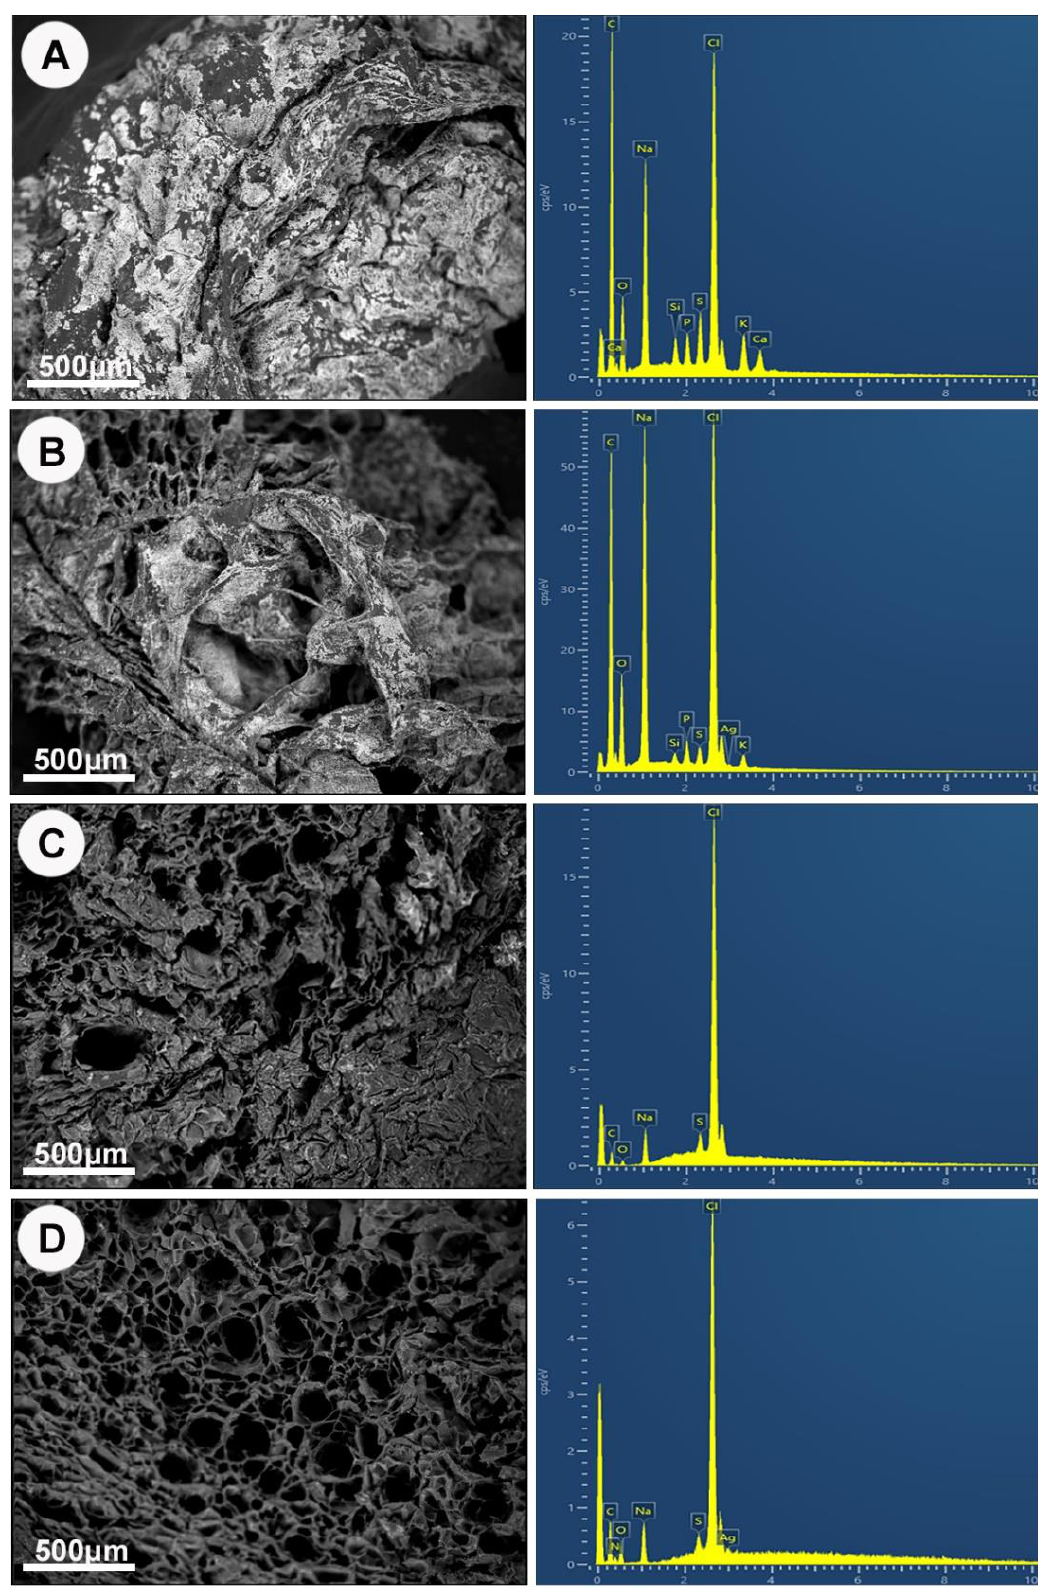
Figure 5. SEM images and respective EDS Spectra of both hydrogels with and without 100 μ g/mL AgNP. ( A ) HyStem ® -C. ( B ) HyStem ® -C with AgNPs. ( C ) GelMA. ( D ) GelMA with AgNPs.